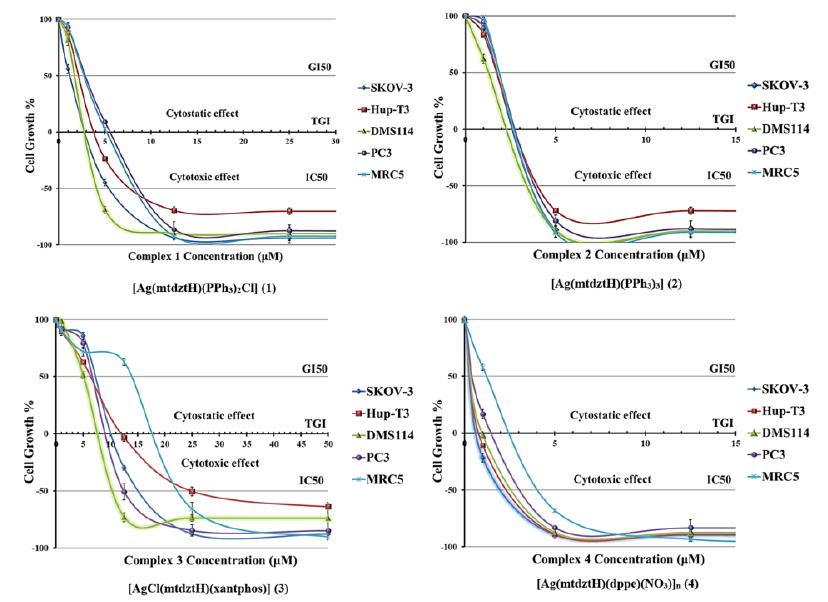
Figure 4. In vitro growth inhibition/cytostatic (GI 50 and TGI, in µ M) and cytocidal/cytotoxic (IC 50 , in µ M) effects induced by compounds 1 – 4 against SKOV-3, Hup-T3, DMS114, PC3 human cancer, and MRC5 human normal cell lines (each point represents mean ± SEM of five measurements. Where error bar is not visible, its size is smaller than that of the corresponding